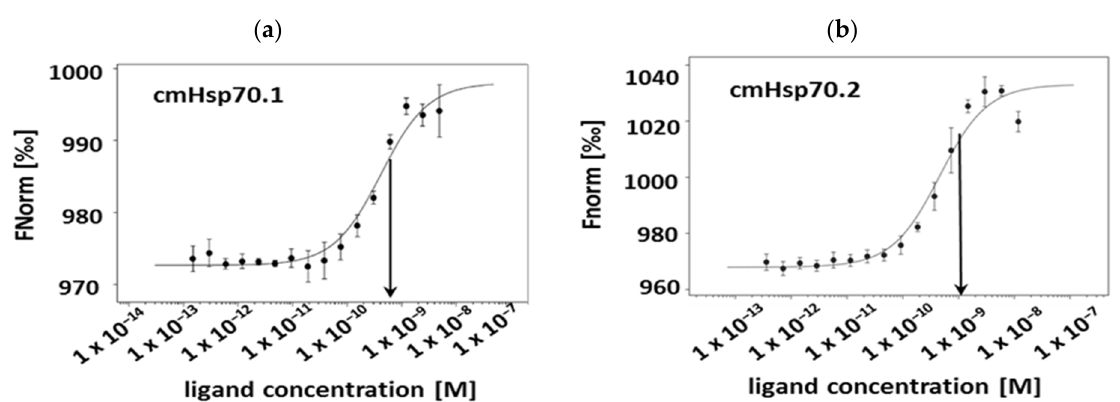
Figure 1. Binding affinity of the cmHsp70.1 and cmHsp70.2 mAbs. The binding affinity of cmHsp70.1 (K D 0.42 nM) ( a ) and cmHsp70.2 (K D 0.44 nM) ( b ) to Hsp70 protein was measured using the Microscale Thermophoresis technique. The X -axis represents the concentration of the Hsp70 protein (M) and the Fnorm (‰) is displayed on the Y -axis. Arrows indicate the determined K D values.